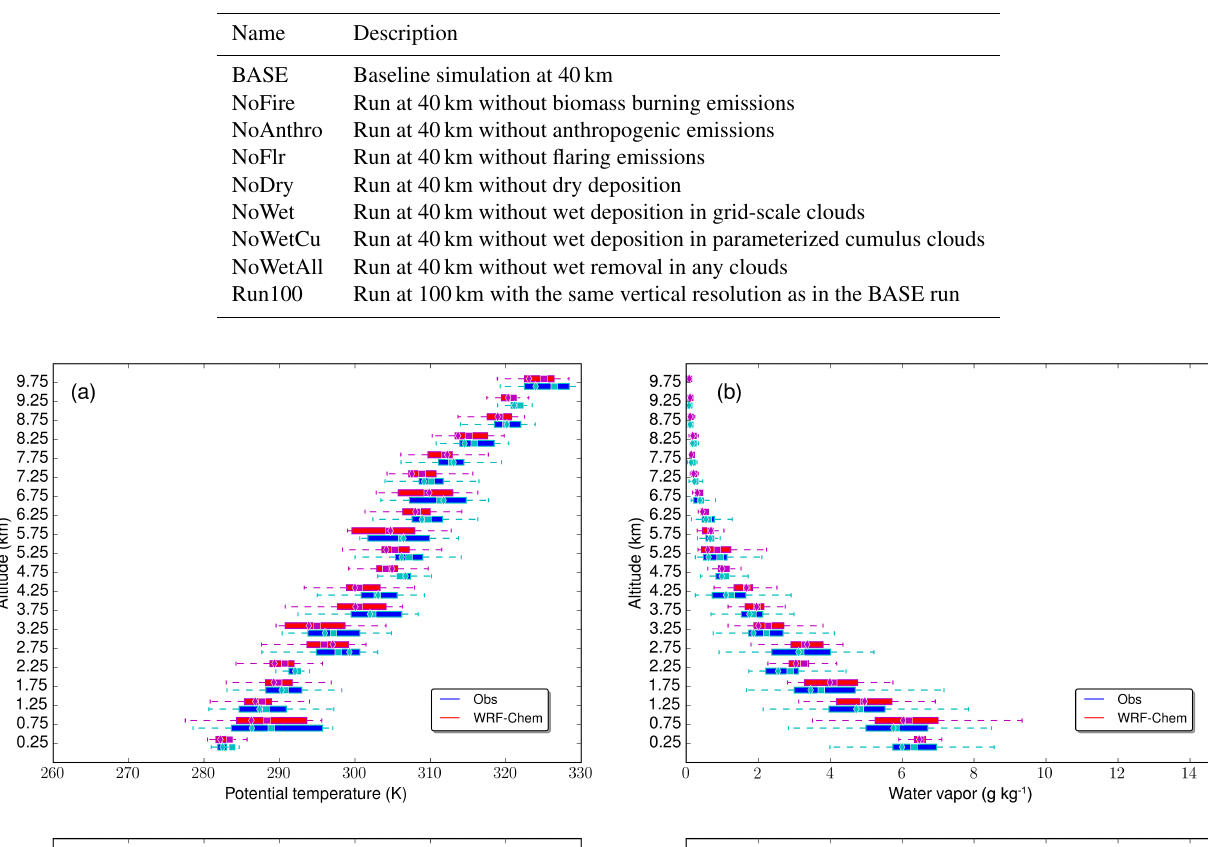
Table 2. List of WRF-Chem simulations performed.